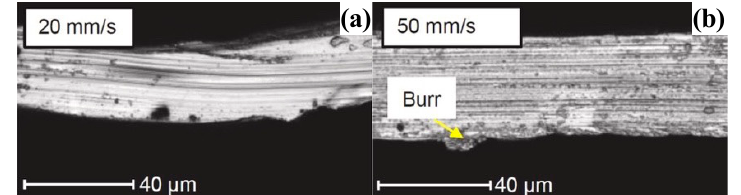
Figure 9. ( a , b ) Compared with the excellent machined surface of La-based amorphous alloy, the machined surface of Fe-based amorphous alloy performs extremely poorly, reprinted with permission from Ref. [79] 2021, Elsevier.